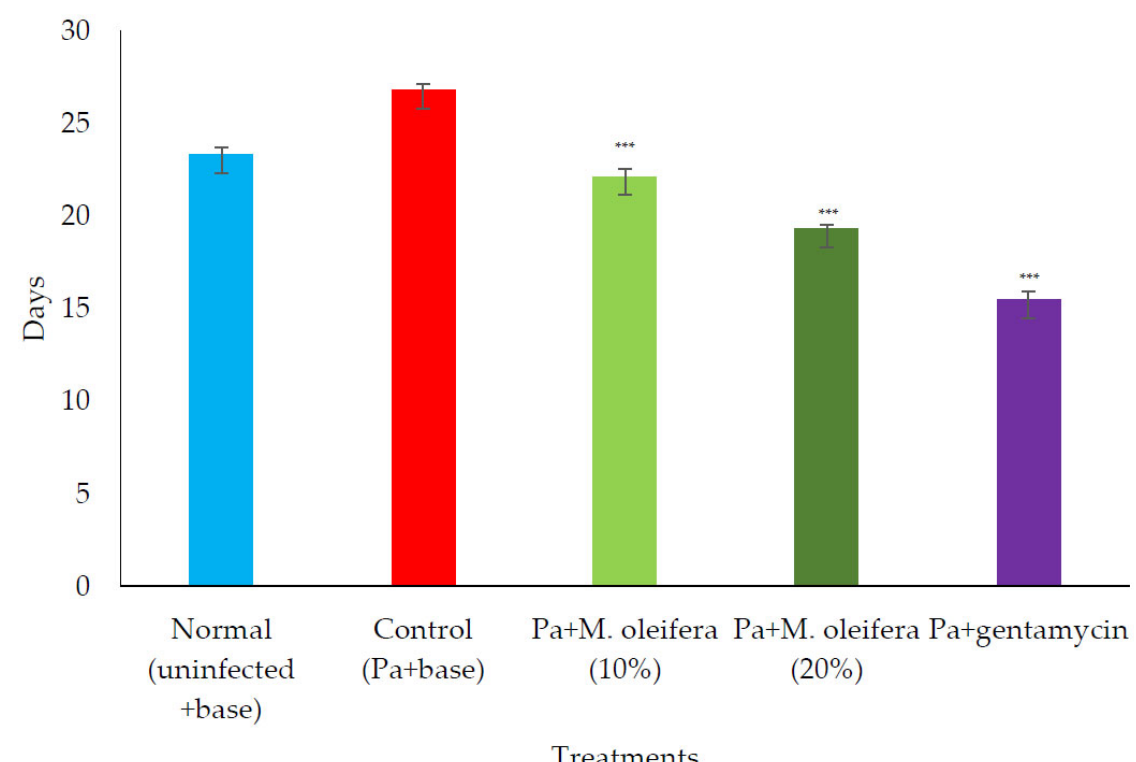
Figure 10. Effect on the period of epithelization in P. aeruginosa (Pa)-infected wounds in rats. All values are mean ± SEM, n = 6, *** p < 0.001 when compared to control (infected). Antioxidant enzymes; SOD and catalase activities were decreased in P. aeruginosa infected wounds. However, the application of the extract (20 % w/w ) increased these enzyme activities, whereas a lower concentration (10% w/w ) had a limited effect on antioxidant enzymes. Application of gentamicin on P. aeruginosa -infected wounds promoted wound healing and increased antioxidant enzymes (Figure 11).